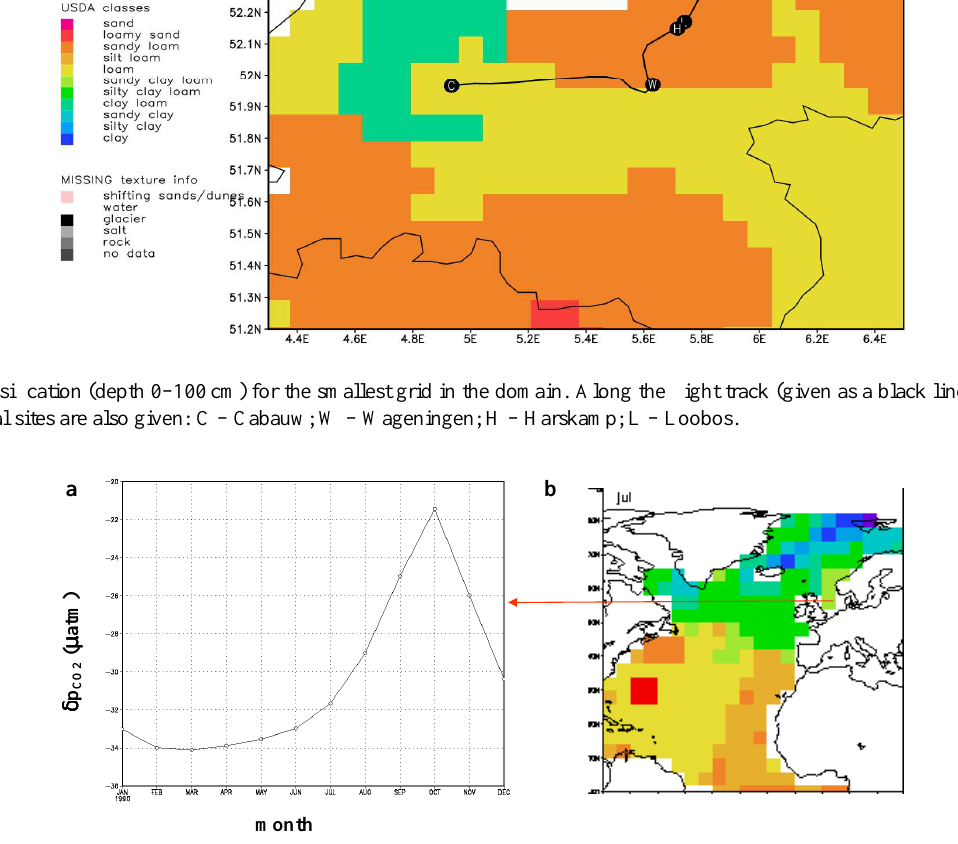
Fig. 5. (a) Monthly dynamics of δp CO 2 (µatm; 1atm=1.01325Pa) as a time series for a pixel in the North Sea (left panel), (b) Spatial representation of δp CO 2 for the Atlantic